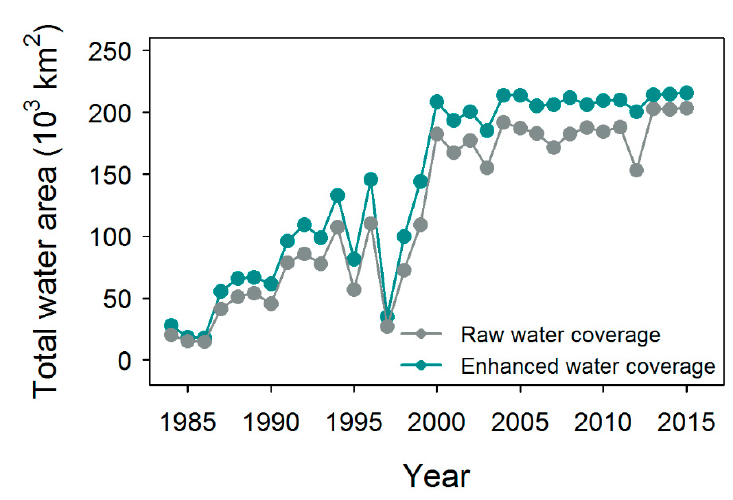
Figure 4. Time series of total water area from August to October, 1984–2015, for 829 lakes and reservoirs. Raw water coverage and enhance water coverage are represented in grey and green, respectively.